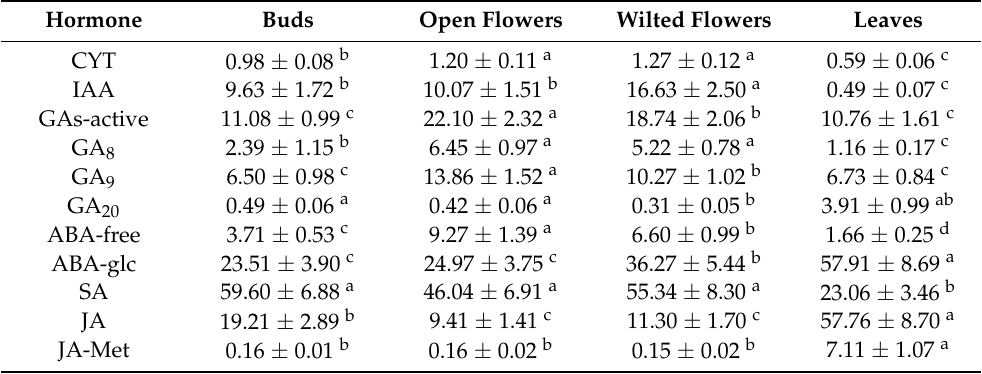
Table 2. Total amount of individual hormones [ µ mol g − 1 dry weight (DW)] in the studied organs of common buckwheat. Mean ( n = 12) ± SE.